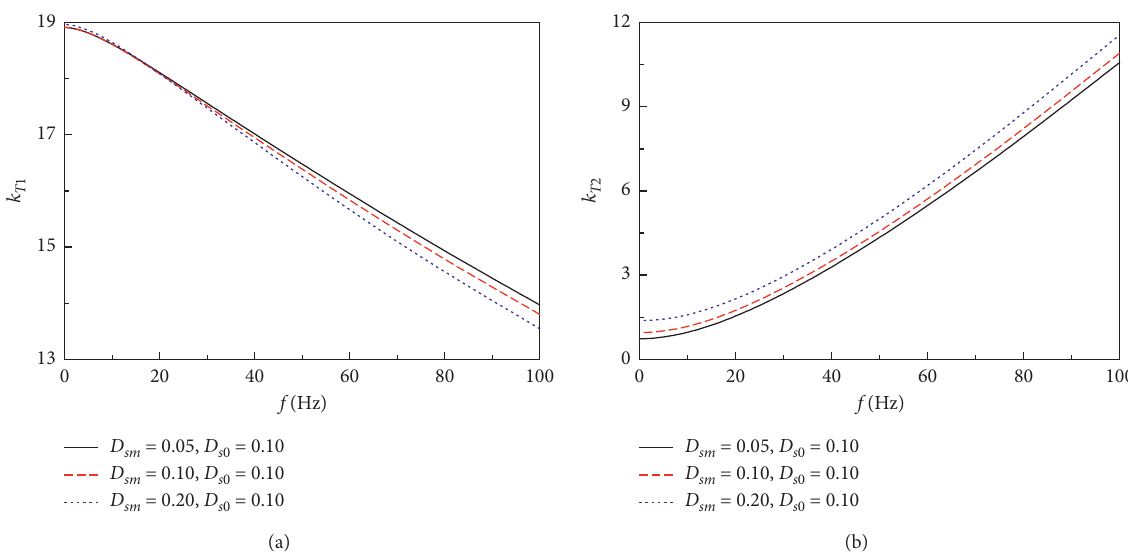
Figure 9: Influence of material damping of the inner disturbed soil on the complex stiffness at the pile top when the inner soil is weakened ( GR � 0.5, t m / r 0 � 0.5).